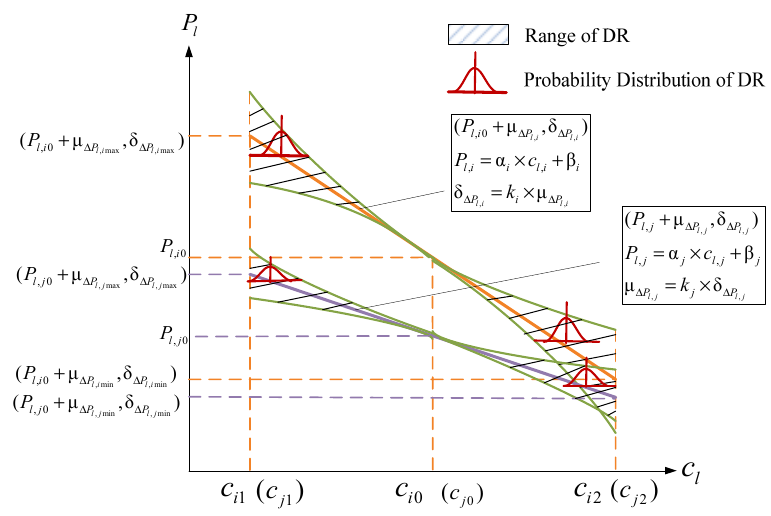
Figure 1. Demand response uncertainty curve of